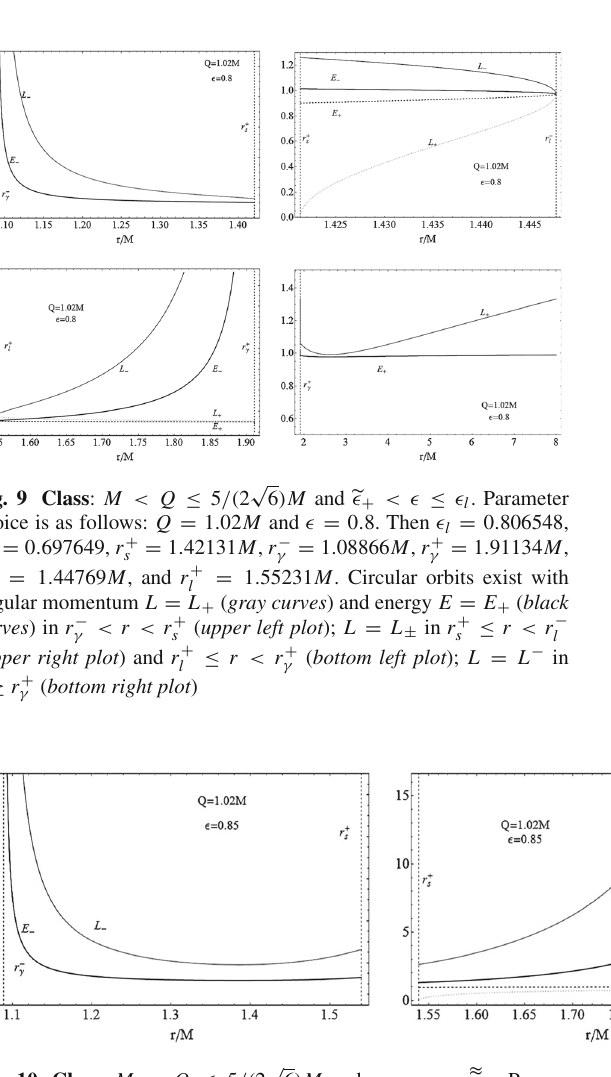
√ Fig. 8 Class : M < Q ≤ 5 /( 2 6 ) M and (cid:9) (cid:2) − ≤ (cid:2) ≤ (cid:9) (cid:2) + . Parameter momentum L = L + ( gray curve ) and energy E = E + ( black curve ) in r − γ < r < r + s ( left plot ); L = 0 at r = r + s ; L = L ± in r + choice is as follows: Q = 1 . 02 M and (cid:2) = 0 . 68. Then (cid:9) (cid:2) − = 0 . 564915, (cid:9) (cid:2) + = 0 . 697649 r + = 1 . 27878 M , r − = 1 . 08866 M , r + = 1 . 91134 M , ( center plot ); L = L − in r ≥ r + γ ( right plot ) γ γ s = 1 . 2788 M and r + = 1 . 7212 M . Circular orbits exist with angular r − l l